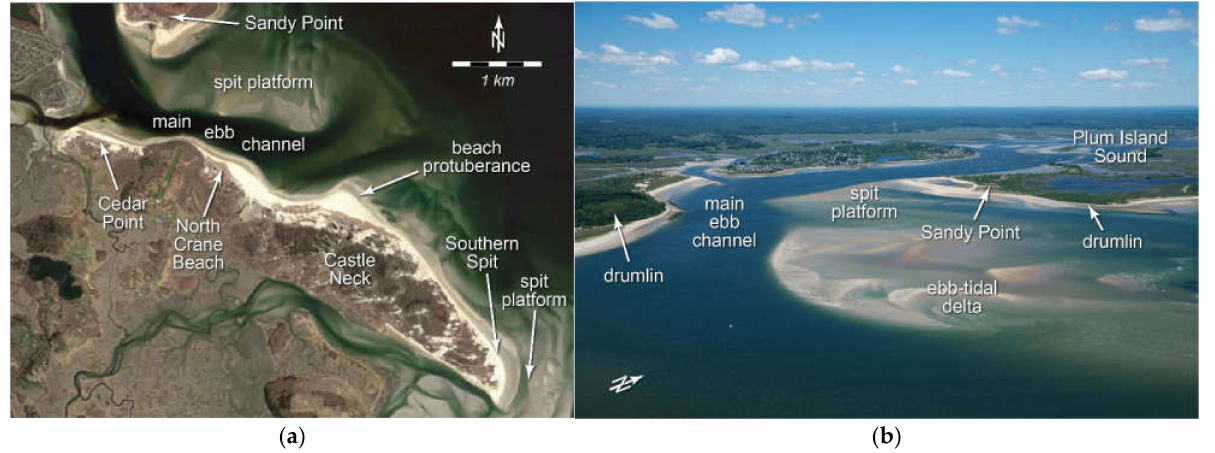
Figure 6. Morphological components of the Plum Island Sound Inlet sand-bypassing system. ( a ) Land- sat satellite image from 14 April 2017. ( b ) Oblique aerial photo looking west into Plum Island Sound